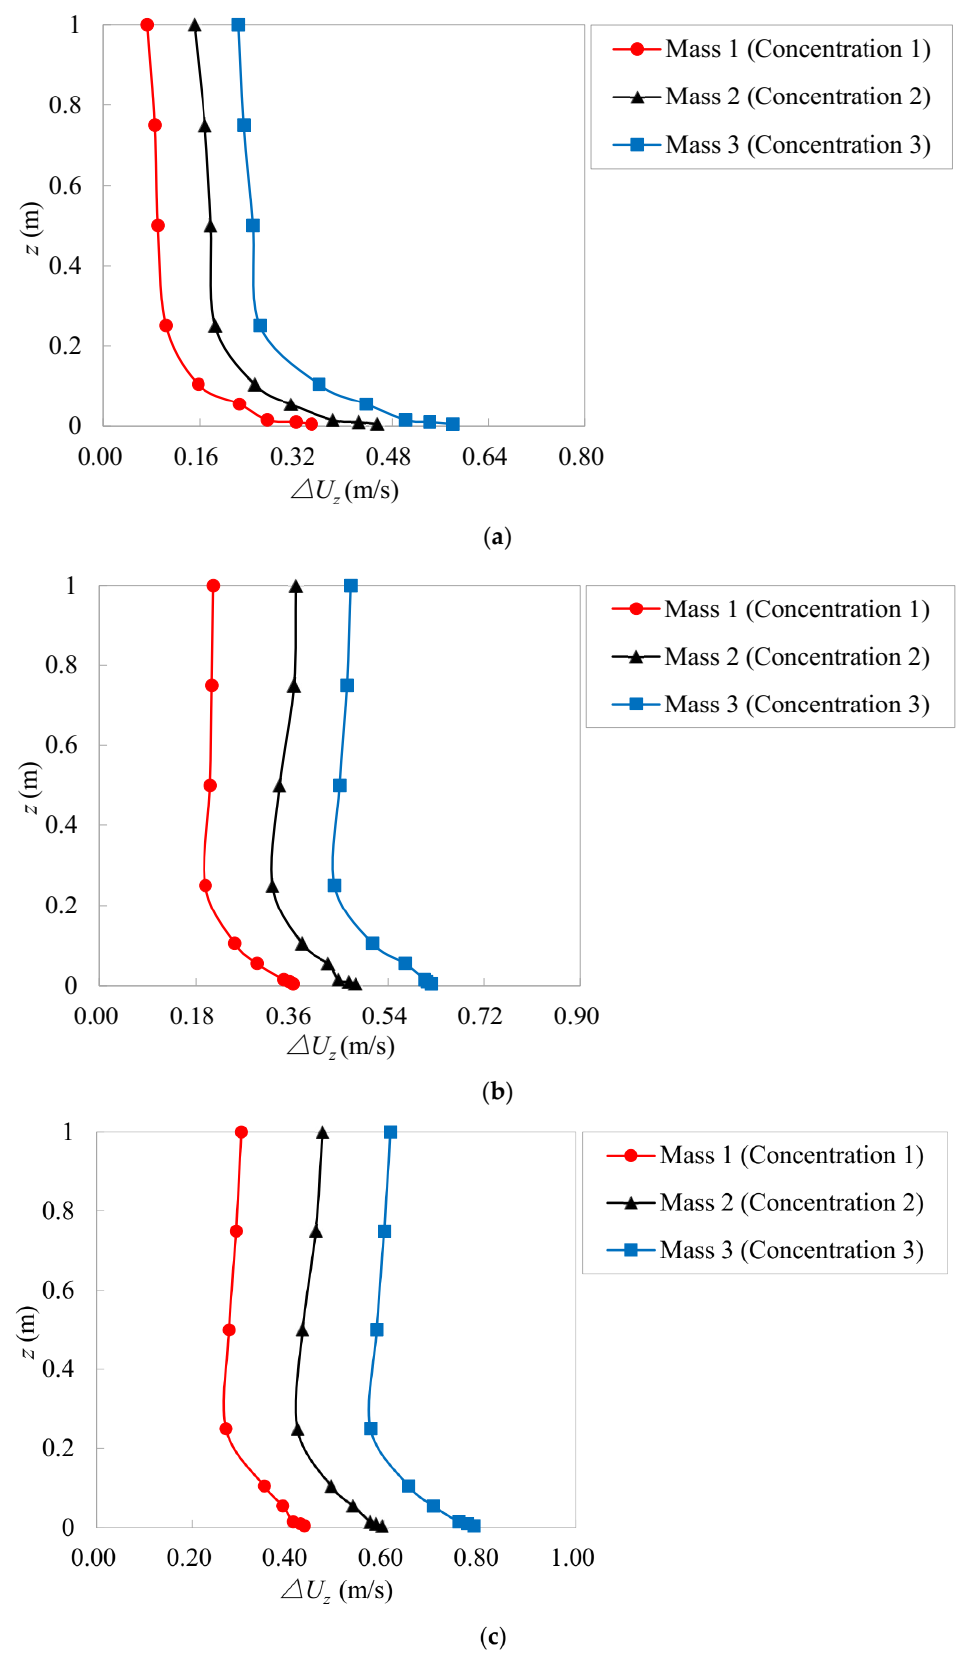
Figure 8. Speed impact values: ( a ) At the test wind speed of 10 m/s; ( b ) At the test wind speed of 13 m/s; ( c ) At the test wind speed of 16